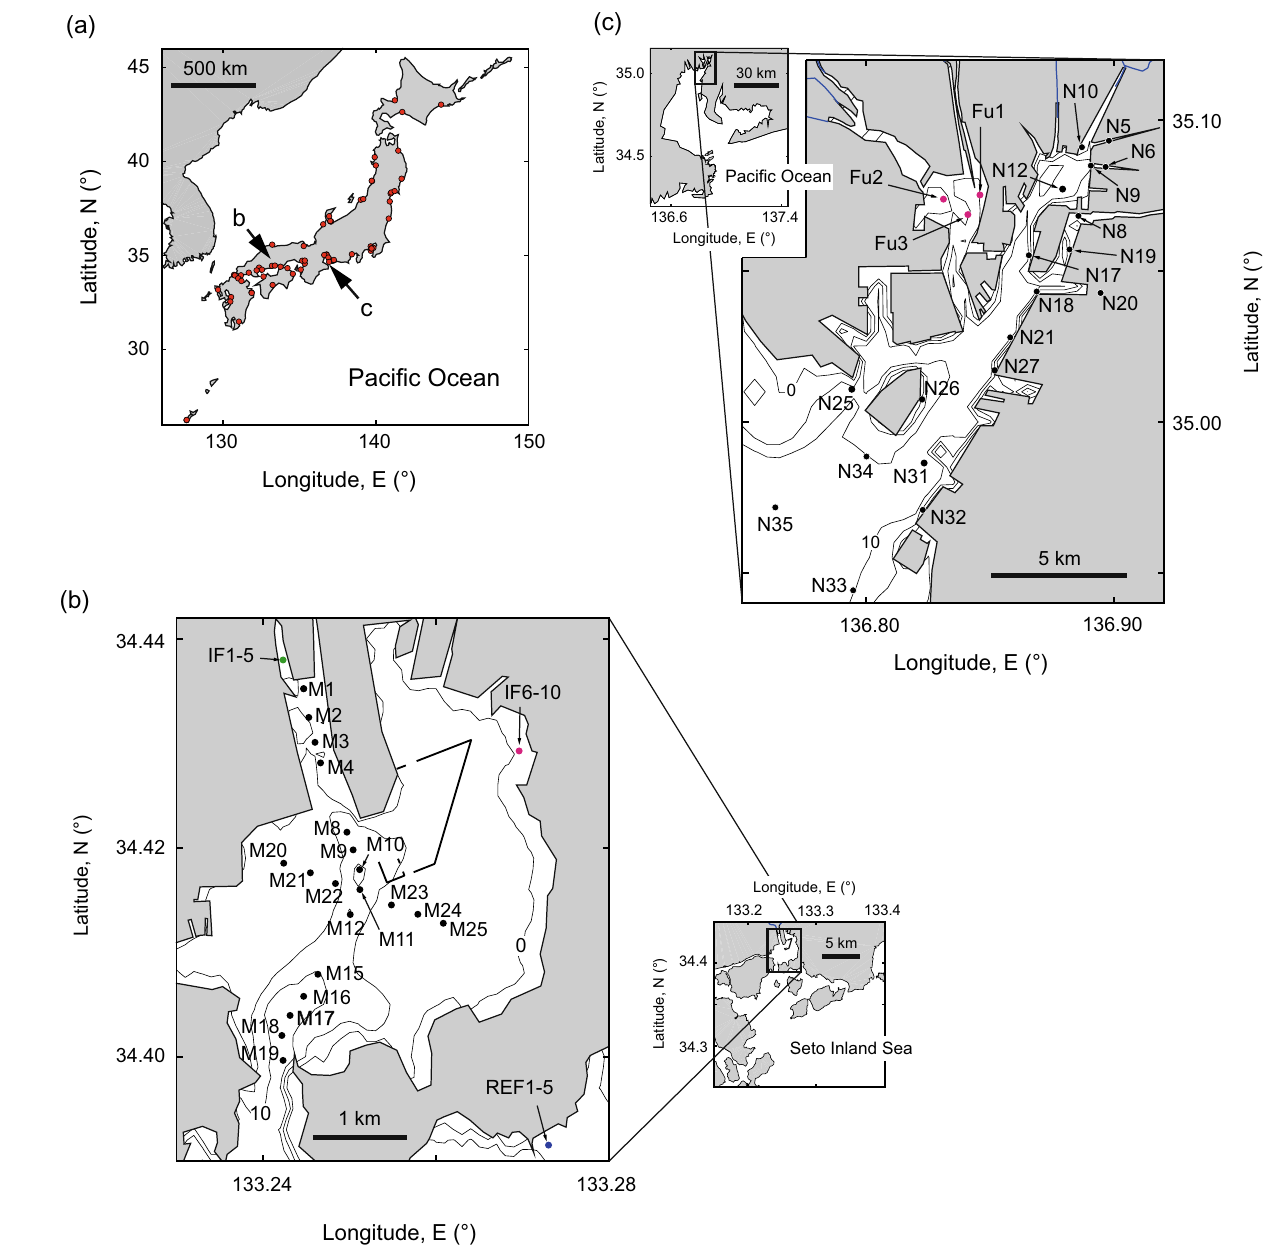
Figure 1. Maps of sampling locations. The number of sampling locations was ( a ) 65 across Japan, ( b ) 30 in Matsunaga Bay, and ( c ) 22 in Nagoya Port. IF1–5 (green) and IF6–10 (magenta) in ( b ) indicate the locations of intertidal flats at the mouth of a small river and in the inner bay, respectively. The location marked REF1–5 (blue) in ( b ) is a reference intertidal flat outside the bay, which was analysed in Supplementary Fig. S6. Locations Fu1–3 in ( c ) are sampling locations on the Fujimae intertidal flat. This map was created based on coordinate data from Google (http:// www. gis- tool. com/ mapvi ew/ mapto coord inates.